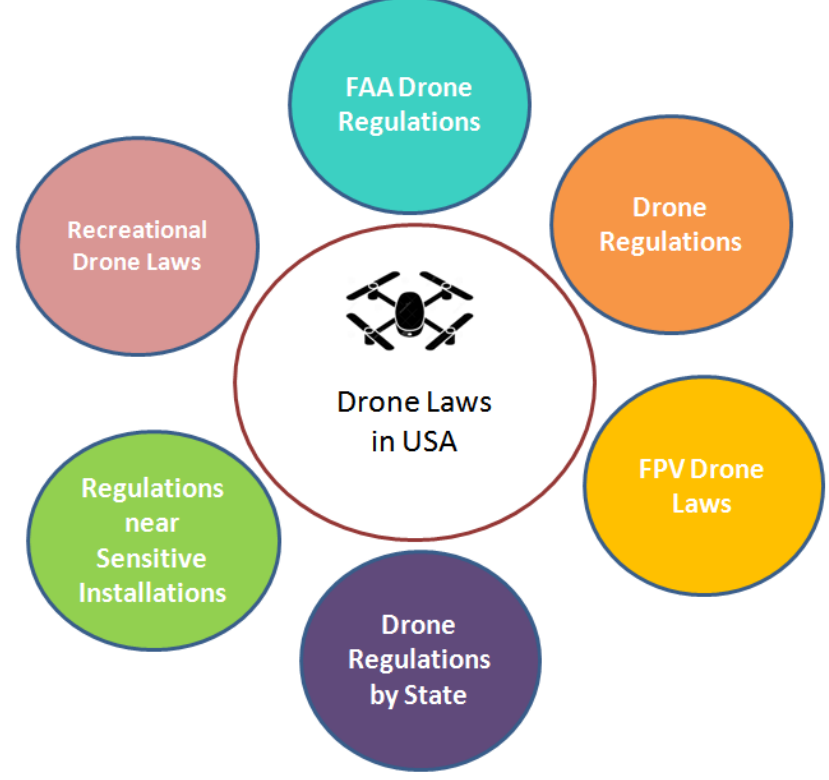
Figure 11. UAV regulations domains.